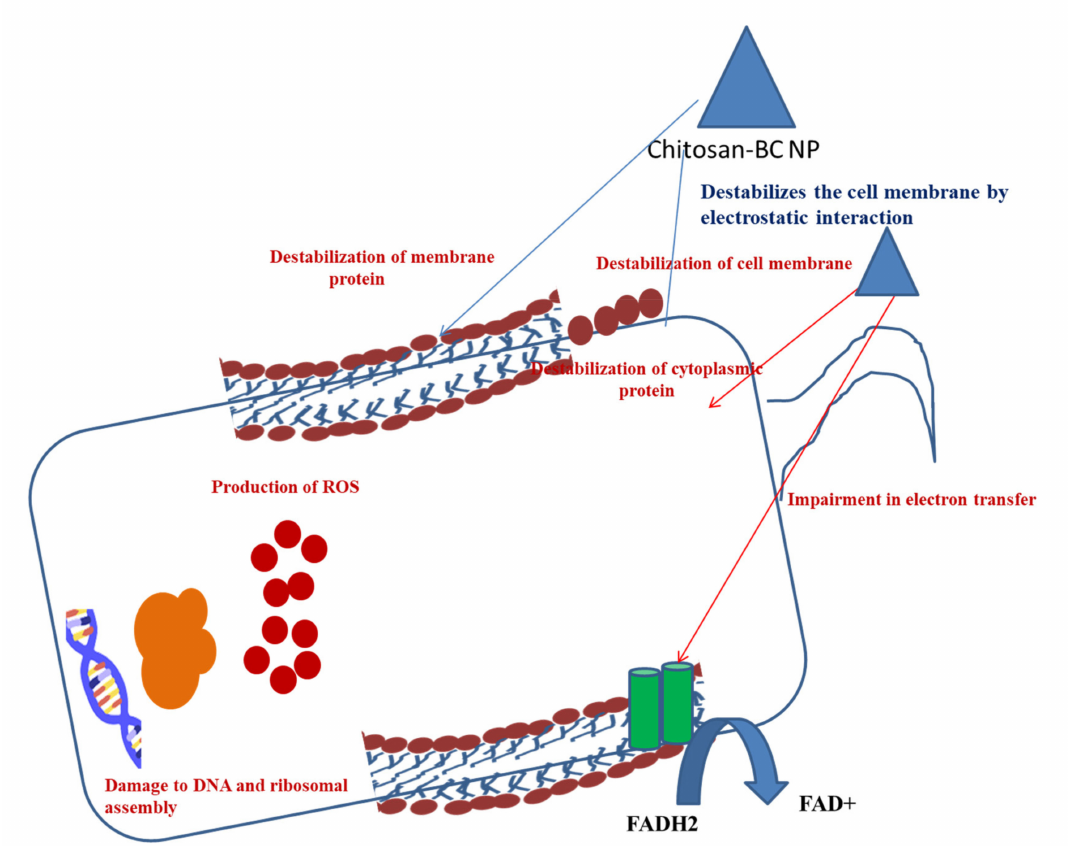
Figure 3. Antimicrobial effects of chitosan BC